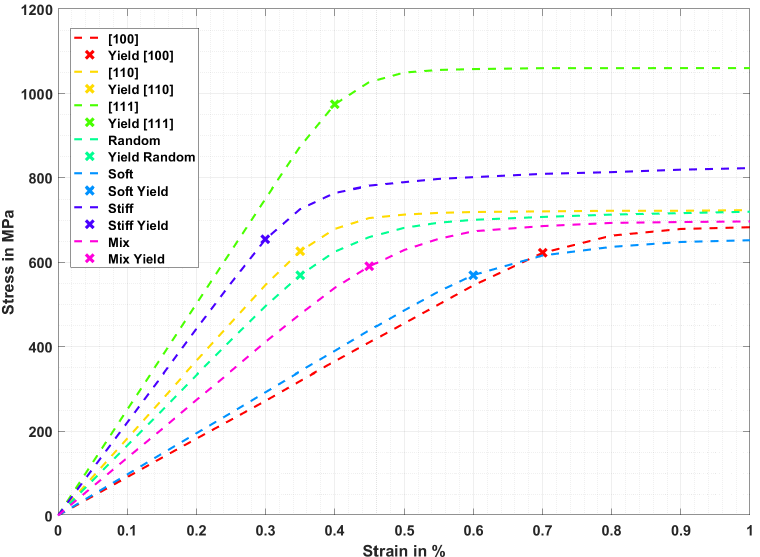
Figure 4. Simulated stress-strain curves for different grain orientation distributions for an INC-738 LC at 850 °C.